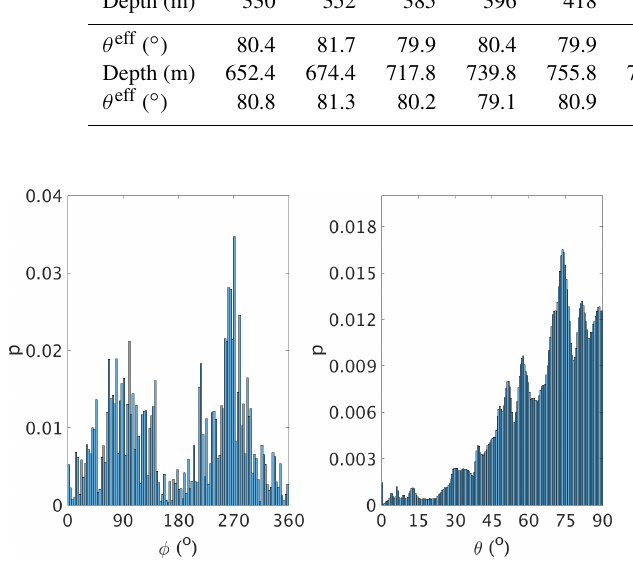
Figure 11. Measured c axis orientation distributions as a function of ϕ and θ at depth 330m. Any measurements with a quality factor of less than 70 were disregarded and not included in the distribution plots (see Peternell et al., 2010, for details about the quality fac- tor). In total, there are qualified 2032533 crystal c axis orientation measurements at this